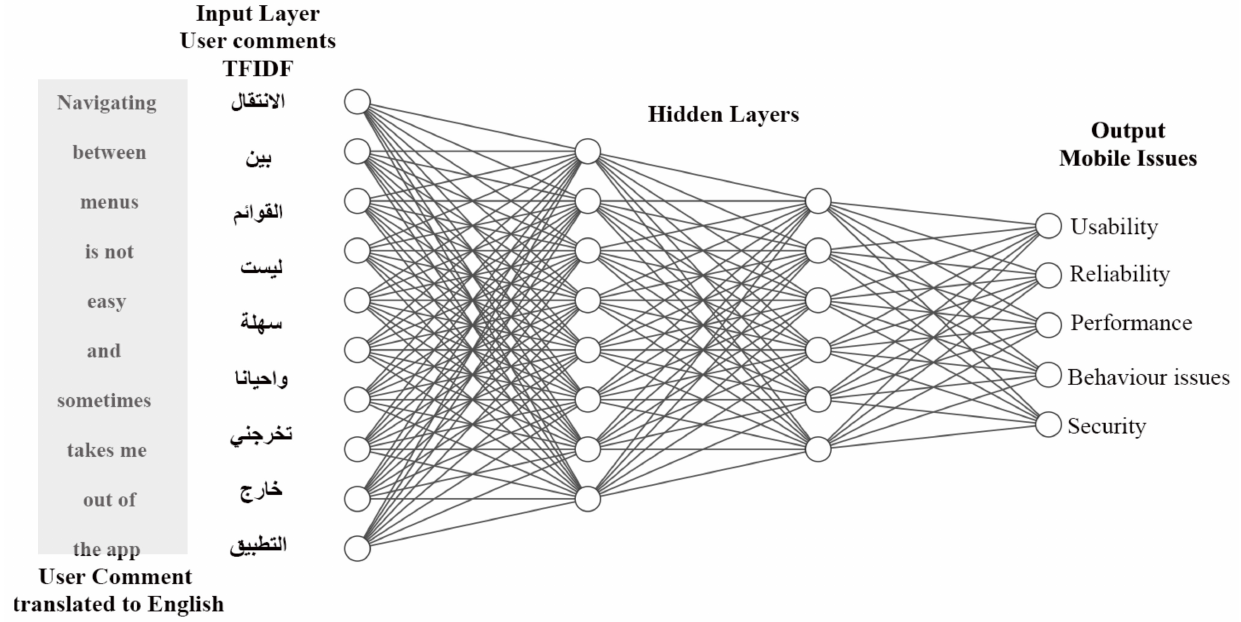
Figure 2. Feed-forward neural